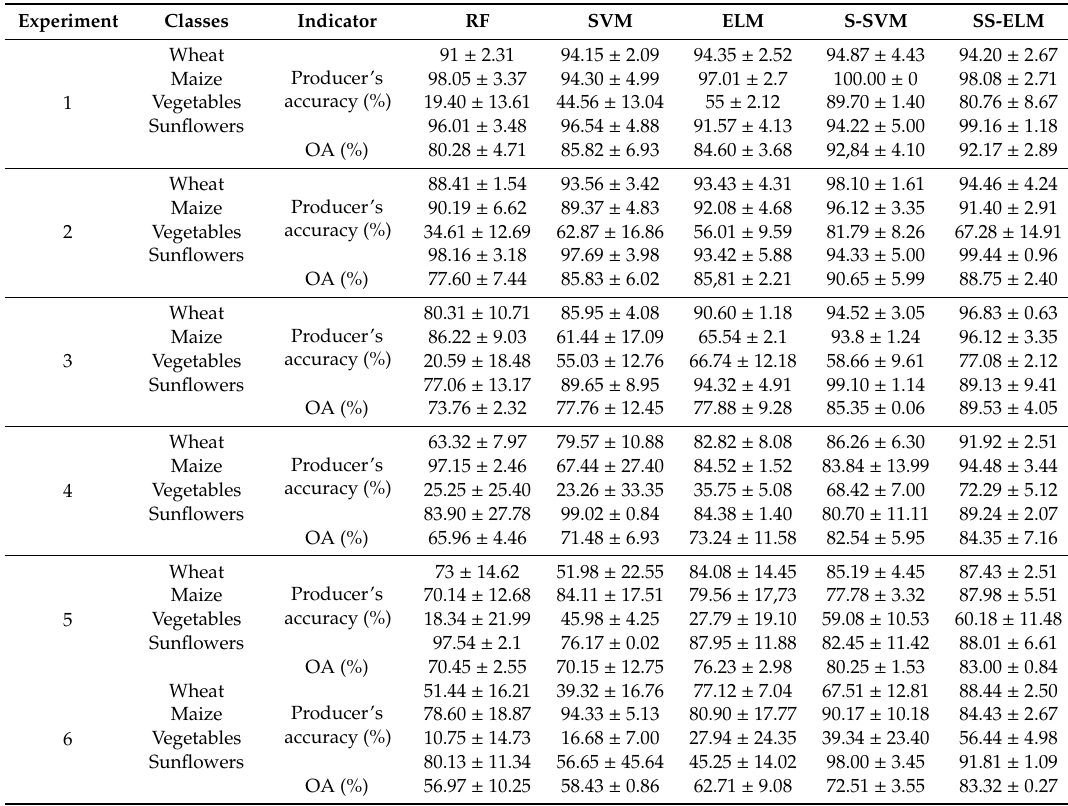
Table 4. Comparison of the classification accuracy of di ff erent algorithms (Average of 20 runs ± standard